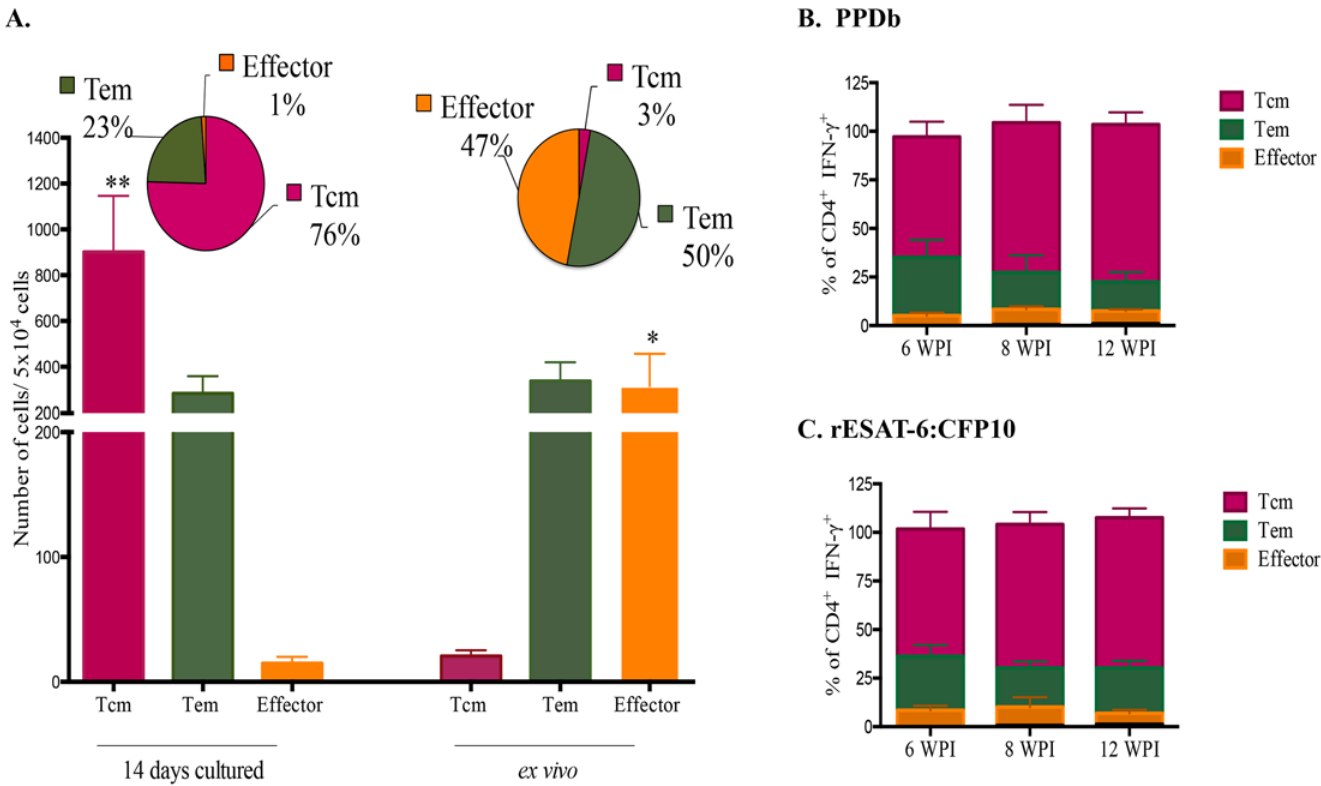
Fig 3. Frequencies of Tcm, Tem and effector cells producing IFN- γ in response to mycobacterial antigens in long-term and ex vivo assays. Peripheral blood mononuclear cells were isolated from calves ~ 8 weeks after challenge with virulent M . bovis . Cells were stimulated with a cocktail of rAg85A (1 μ g/ml), rTB10.4 (1 μ g/ml), and rESAT-6:CFP10 (1 μ g/ml) as well as PPDb (5 μ g/ml) for 13 days followed by transfer to 96 well round bottom plates with APCs and addition of media alone, PPDb or rESAT-6:CFP10 for an additional 16h. For ex vivo culture, PBMC were stimulated with media alone, PPDb or rESAT-6:CFP10 for 16 h. (A) Relative contribution of Tcm, Tem, and T effector cells to IFN- γ production in response to PPDb by long-term (i.e., 14-day) (left) and ex vivo (i.e., 16 h) (right) cultures, 8 weeks after M . bovis challenge. Data are presented in percentages (pies) and as mean ( ± SEM) number of cells producing IFN- γ / 10 4 cells (histograms) (n = 16). Relative contribution of Tcm, Tem and T effector cells to IFN- γ production in response to PPDb (B) or to rESAT-6:CFP10 (C) in long-term cultures at three, six, eight or 12 weeks post-infection (WPI, n = 6). Tcm, Tem and effector cell phenotypes were as defined in Fig 2 and S3 Fig Tcm and Effector T cell contribution to IFN- γ production differs ( * P < 0.05; ** P < 0.01, paired Student's t-tests) between short- and long- term